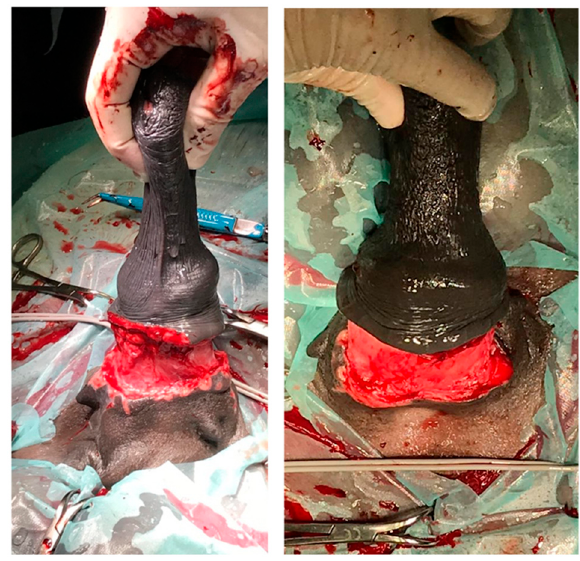
Figure 12. Subtotal preputial resection (clinical case 1). Distally and proximally to the lesion, two parallel incisions, through the preputial epithelium were made (Figure 13-Blue); the distal circular incision was made at the limit between the inner lamina of the internal fold and the free portion of the penile body, and the proximal incision at the level of the external preputial orifice.